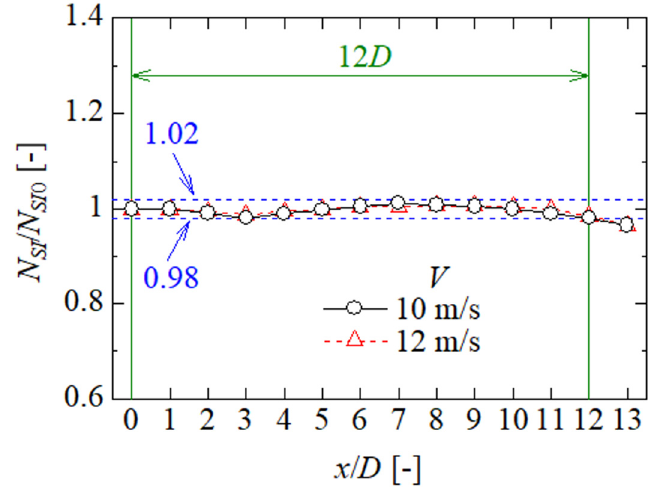
Figure 6. Free rotational speed of the single rotor along the streamwise direction at y = 0 mm.